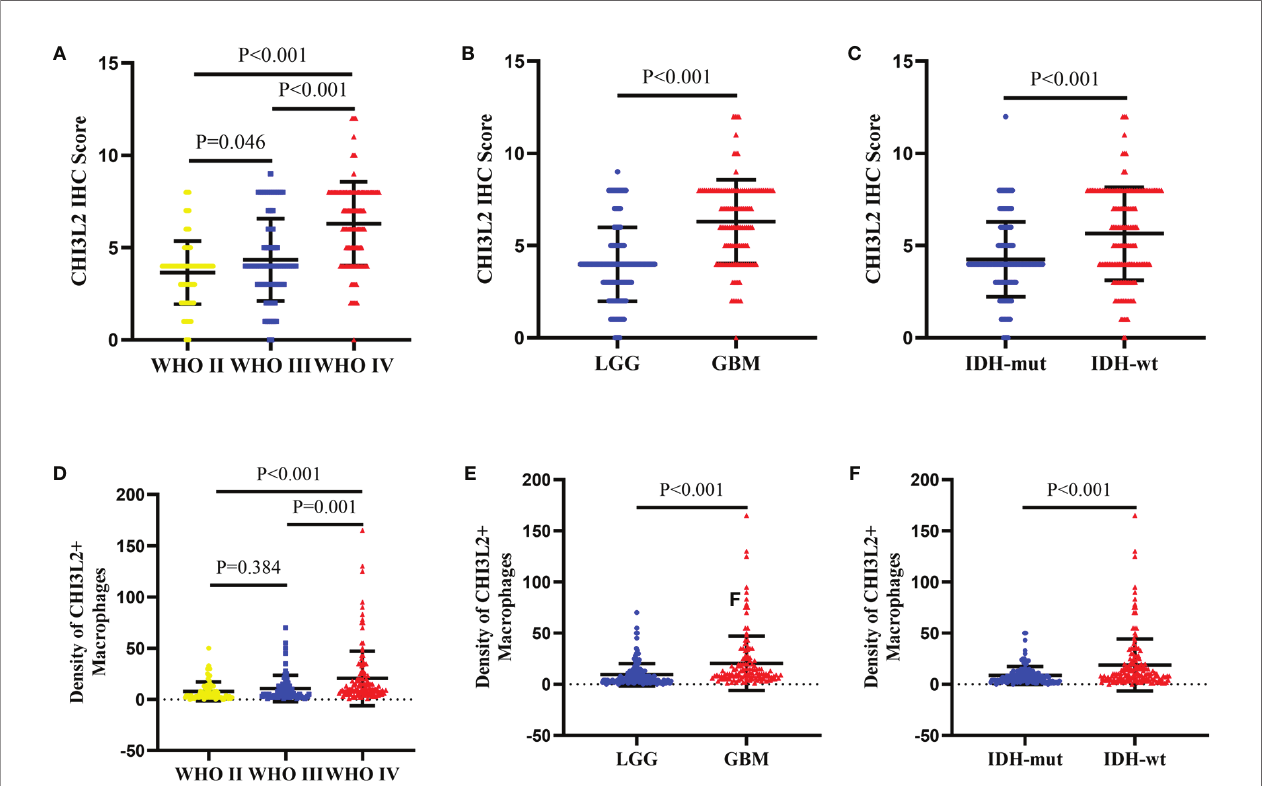
FIGURE 2 | The protein expression levels of CHI3L2 in different subgroups of gliomas. (A) The IHC score in diffusely in fi ltrating glioma (WHO II-IV). (B) The IHC score in LGG and GBM. (C) The IHC score in diffusely in fi ltrating glioma with different IDH status. (D) The density of CHI3L2+ macrophages in diffusely in fi ltrating glioma (WHO II-IV). (E) The density of CHI3L2+ macrophages in LGG and GBM. (F) The density of CHI3L2+ macrophages in diffusely in fi ltrating glioma with different IDH